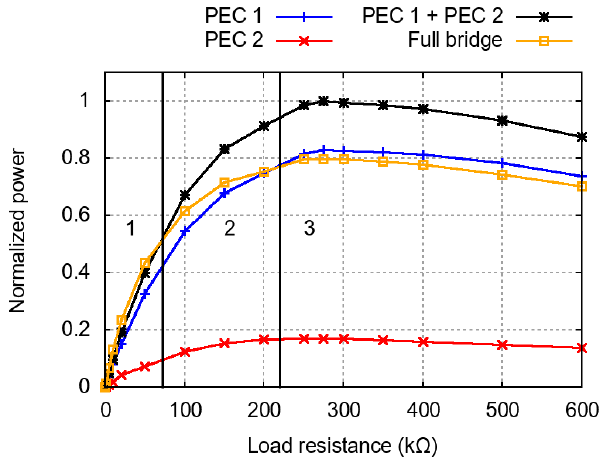
Figure 12. Dependence of the normalized electrical power on the load resistance.